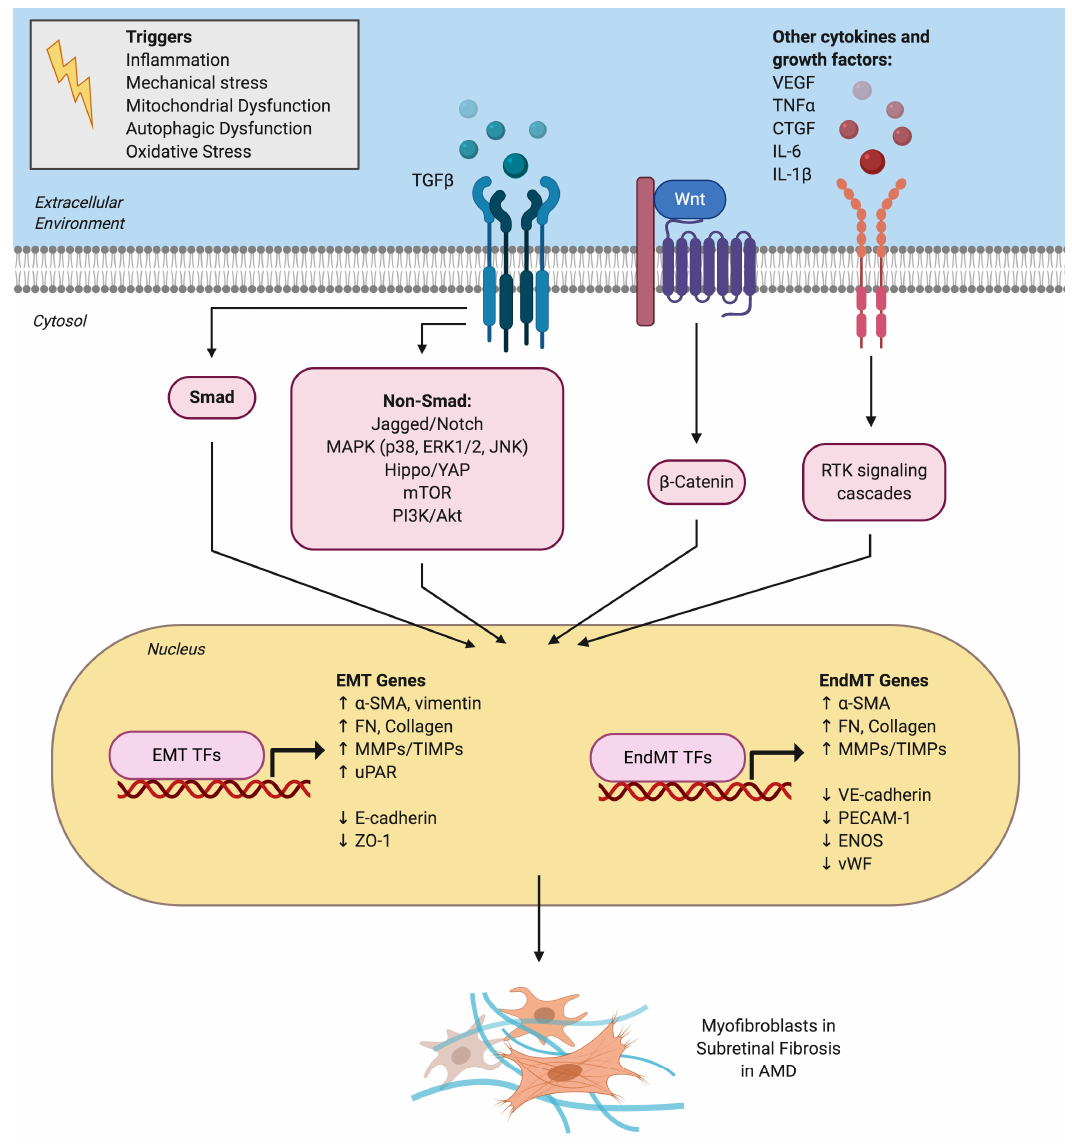
Figure 2. Signaling pathways and mechanistic drivers of epithelial-mesenchymal transition (EMT) and endothelial-mesenchymal transition (EndMT) in age-related macular degeneration (AMD). Various extracellular cytokines and receptor tyrosine kinase (RTK) signaling pathways are involved in activating EMT of retinal pigment epithelial cells and EndMT of choroidal endothelial cells. TGF β is the master regulator and activates both the canonical Smad signaling pathway and a host of non-canonical signaling pathways. The Wnt / β -catenin signaling pathway also plays a key role in both EMT and EndMT. Activation of EMT and EndMT results in the upregulation of various transcription factors (TFs) such as Snai1 and mesenchymal genes and the downregulation of epithelial or endothelial genes, respectively. This ultimately leads to myofibroblast transdifferentiation and excessive extracellular matrix deposition observed in subretinal fibrotic lesions in AMD. β -catenin is sequestered and maintained by cadherins at adherens junctional complexes [56]. However, once EMT or EndMT is activated, β -catenin takes on a new role as a signaling molecule for the Wnt pathway as it disassociates from the cadherins at the membrane, translocates to the nucleus and binds to the TCF/LEF family of transcription factors to activate EMT and EndMT transcription